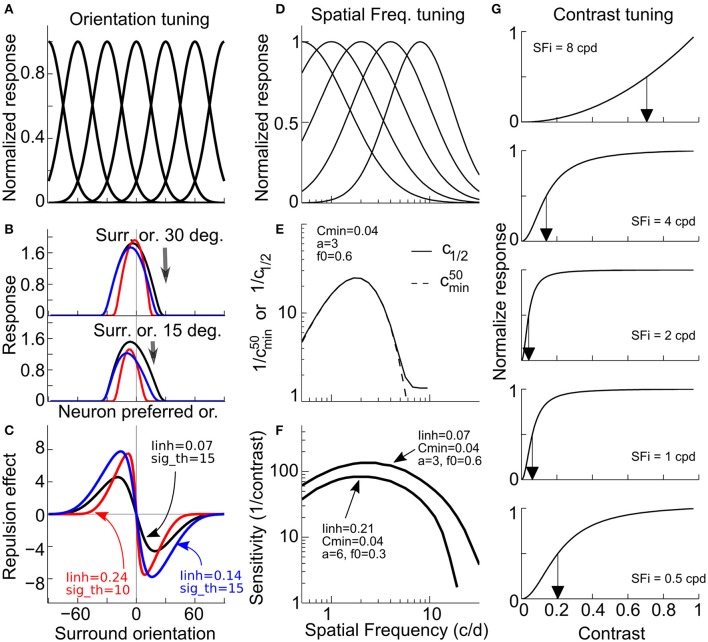
V1 model illustration. (A–C) Example and prediction for orientation coding and decoding. (A) Uniform orientation tuning of the neuronal population. (B) Response of the neuronal population to center of 0°. and two different surround orientations of ±30° (top) and ±15° (bottom). (C) Orientation prediction of the model from the population responses for various surround orientations. Examples for three different set of parameters in red, black and blue. (D–G) Example and prediction for (SF) and contrast tuning coding and decoding. (D) SF tuning examples, with the characteristic tuning width decrease with increasing preferred SF. (E) Example of the relation between the minimum contrast semi-saturation constant and preferred SF. (F) Examples of CSF prediction for two sets of model parameters. (G) Examples of contrast response functions in the model for the minimum semi-saturation constant at few preferred SFs (arrows depict half-amplitude constant).